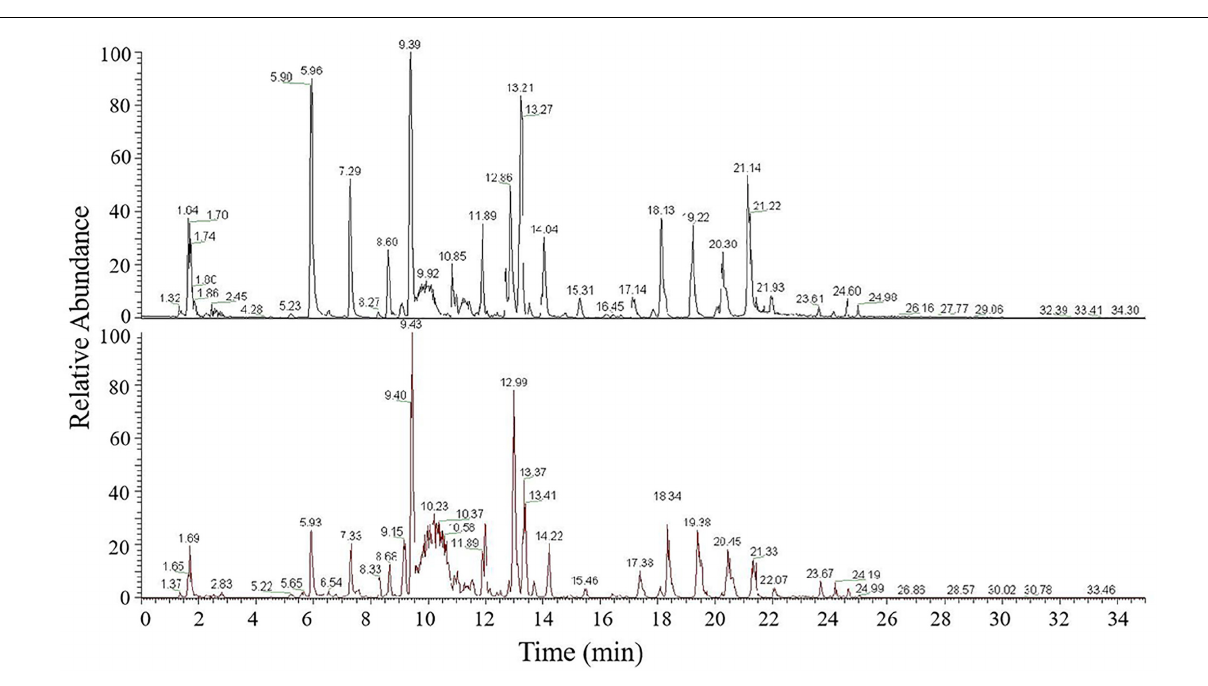
Frontiers in Plant Science |